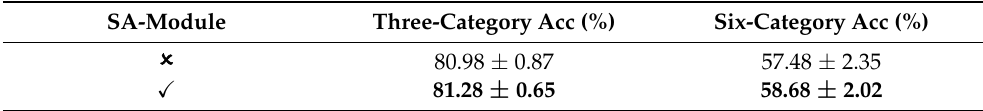
Table 10. Results on Effectiveness of SA-Module.